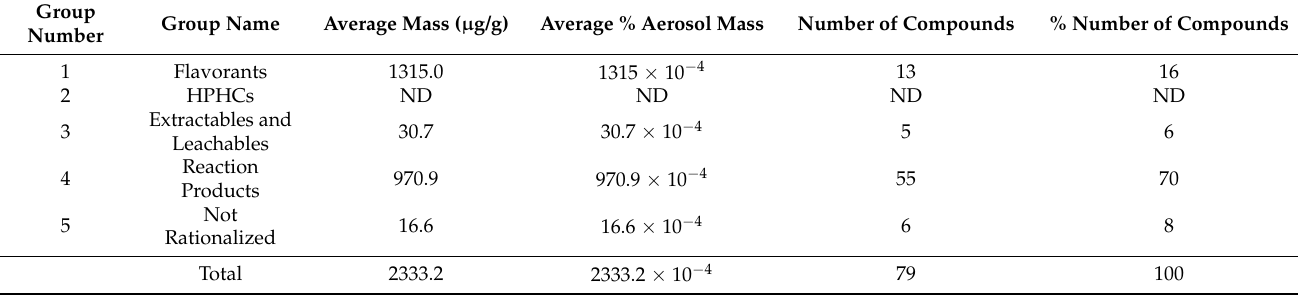
Table 5. Summary of Non-Targeted Analyses of VT3 Aerosol Using the Intense Puffing Regimen.